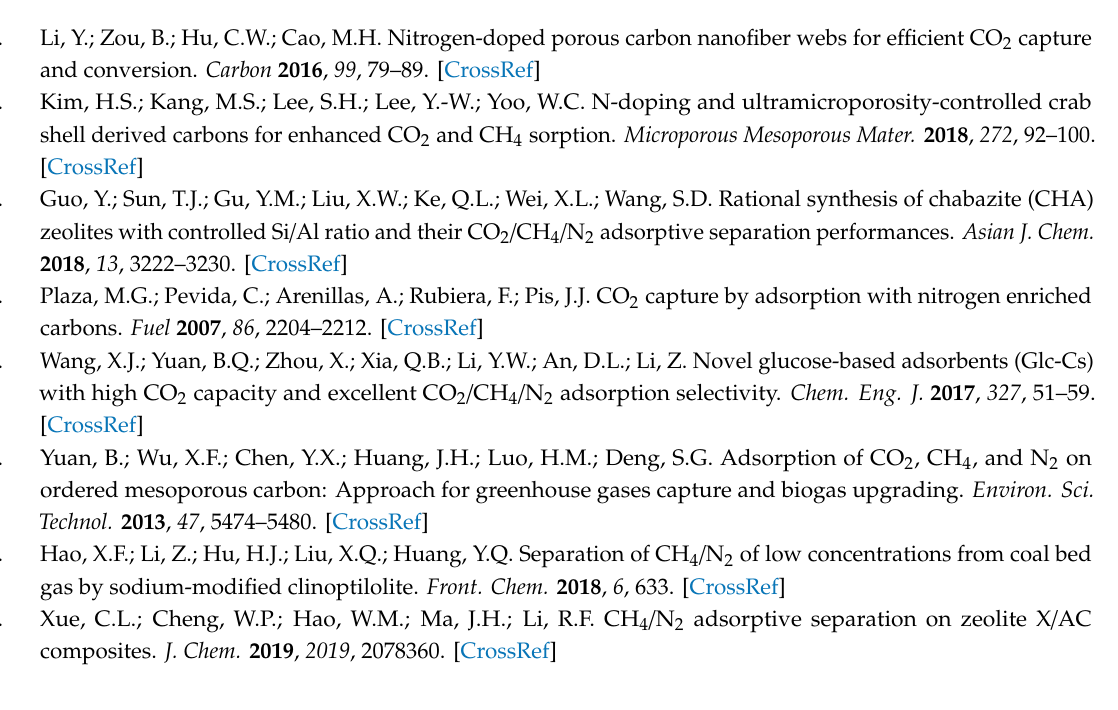
Figure S1: XPS high-resolution of (a,b,c) C1s and (d,e,f) O1s for the porous carbon samples ACSs-N, NCSs and ACSs, Figure S2: Adsorption isotherms of (a) CO 2 , (b) CH 4 , and (c) N 2 on ACSs-N at high pressure. The marker points represent the experimental data, while the black solid lines correspond to Langmuir-Freundlich equation fittings, Table S1: The gas adsorption performance for porous materials from reported results, Table S2: Summary of the gas capacities of the ACSs-N under high